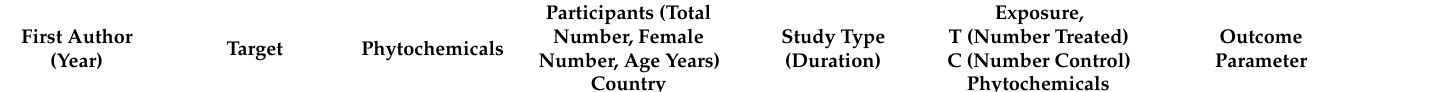
Table 7. Summary of selected studies regarding the therapeutic area of energy and